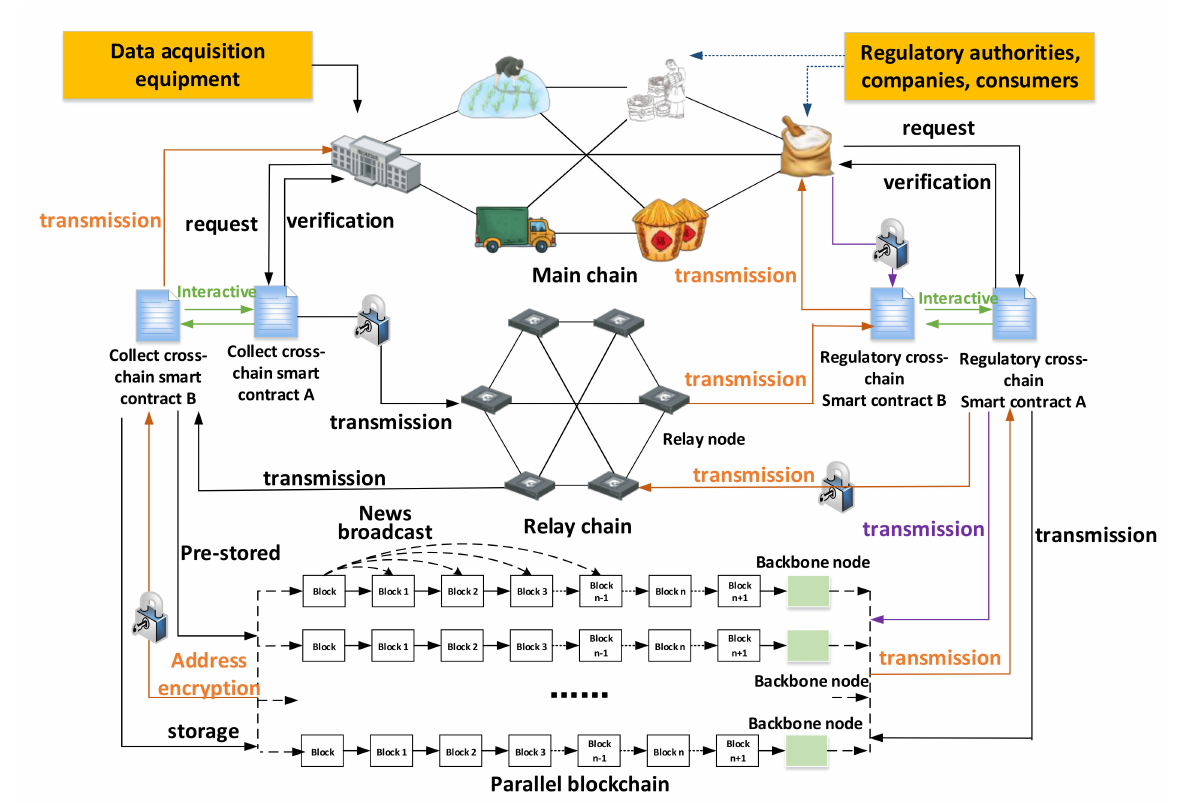
Figure 8. Schematic diagram of mode